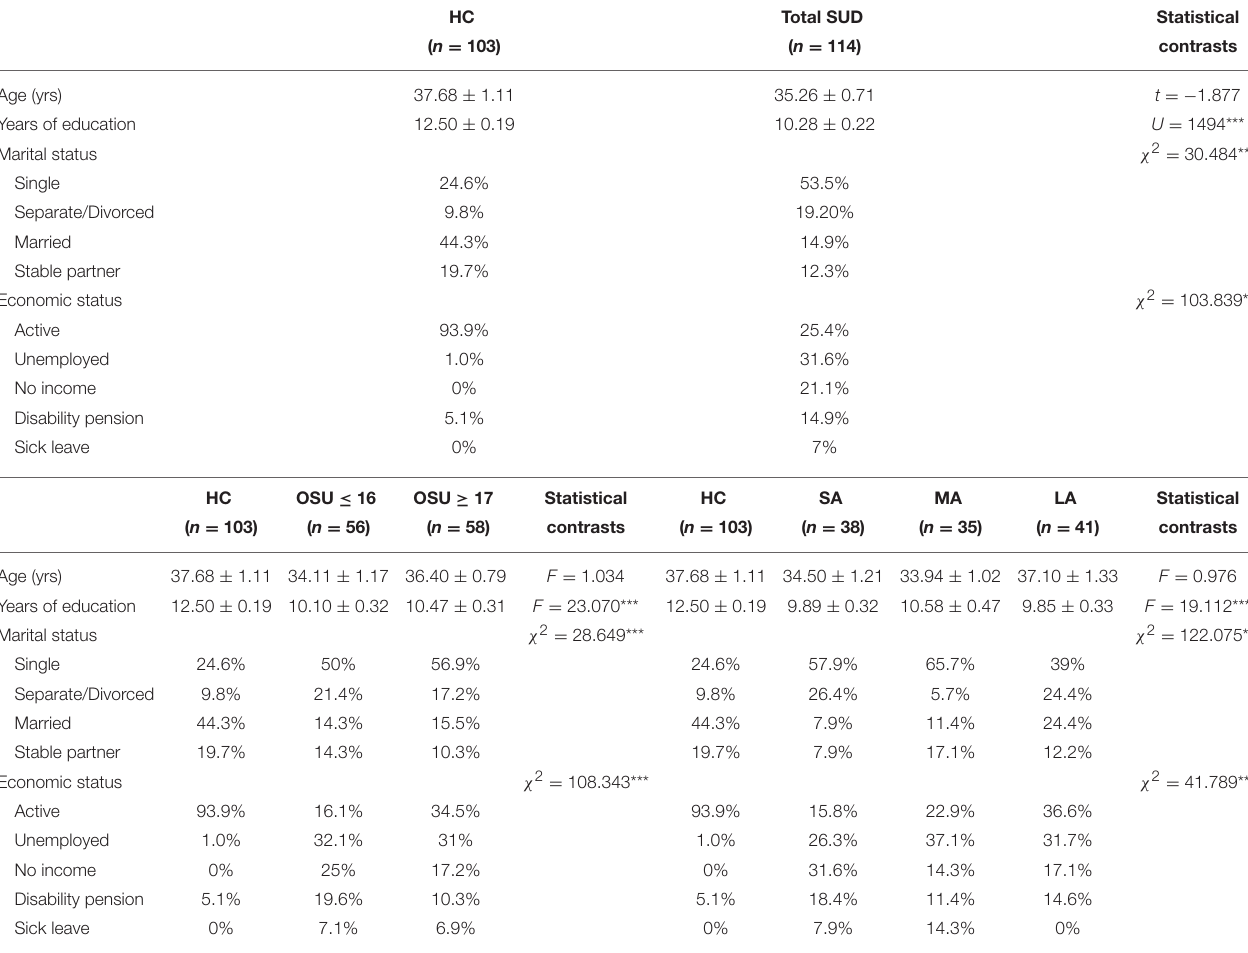
TABLE 1 | Sociodemographic data for all